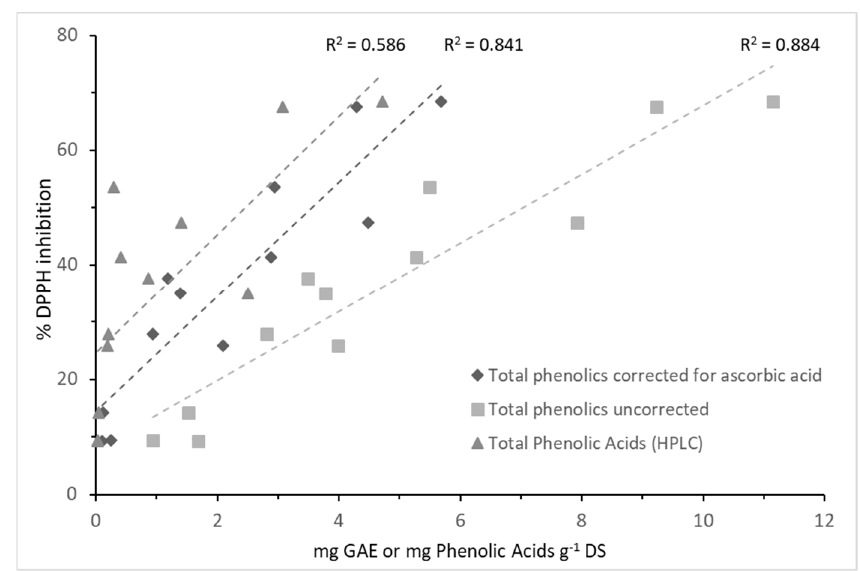
Figure 4. Scatter plots of the radical scavenging activity (% inhibition of DPPH) in ethanol extracts of Jerusalem artichoke plant organs, versus uncorrected and corrected total phenolic content, and the total phenolic acids analyzed by HPLC-UV. Coefficient of determination (R 2 ) for the three plots are 0.884, 0.841, and 0.586, respectively.